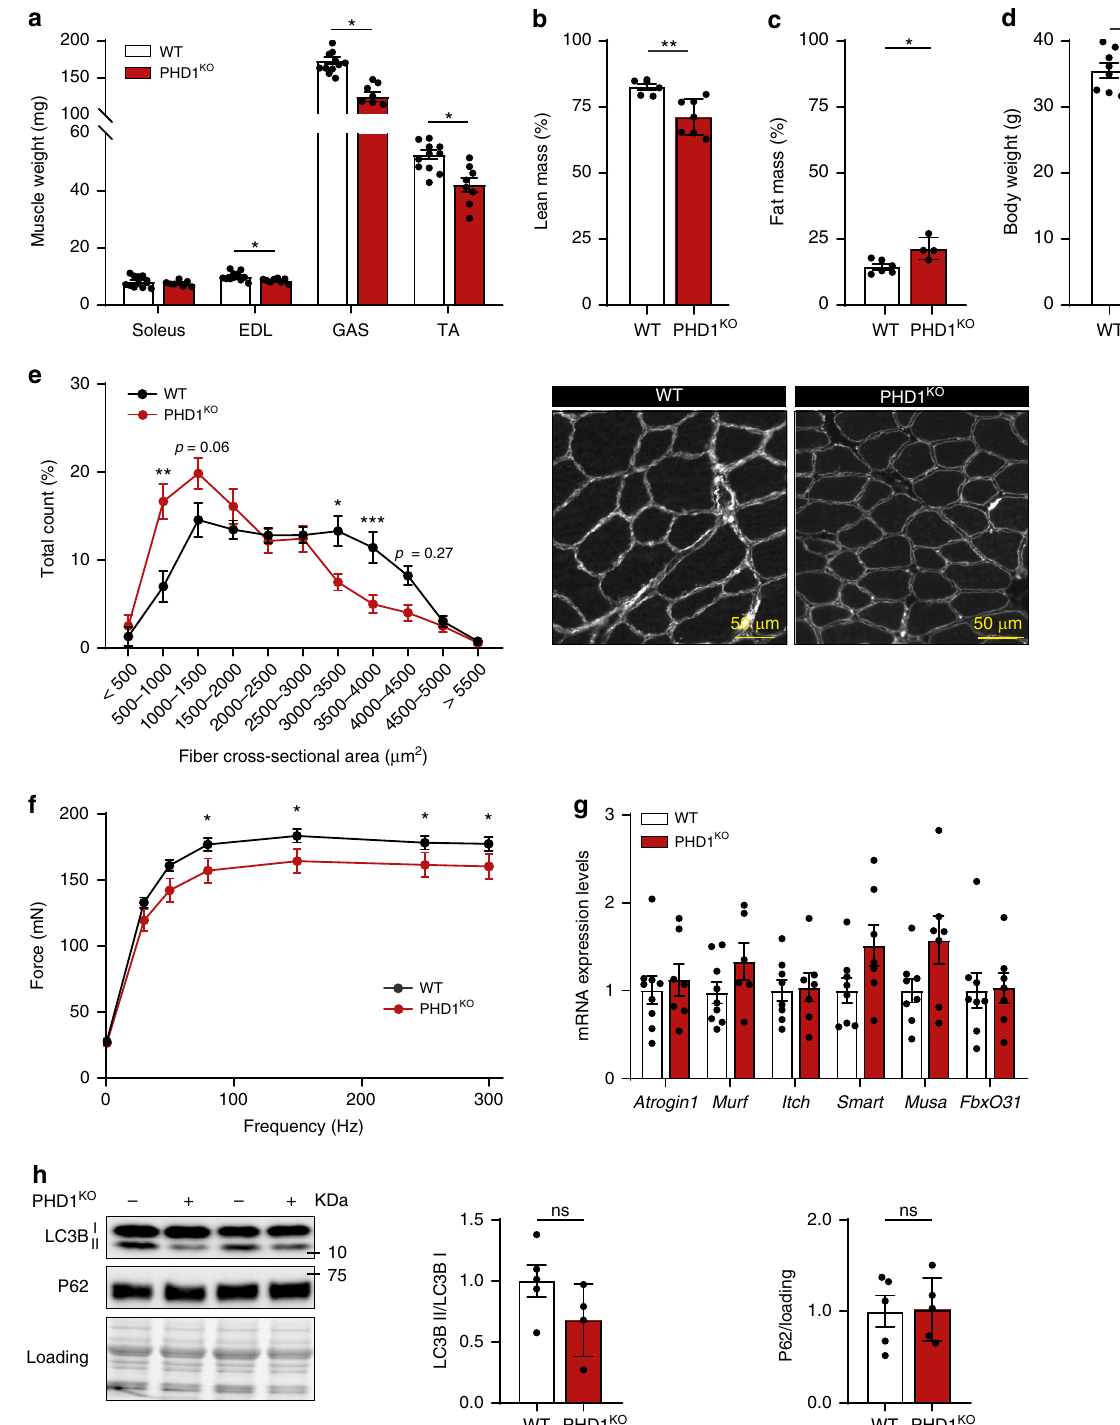
Fig. 1 Phd1 -de fi cient mice have lower muscle mass. Bar graphs showing muscle weight ( a ), lean mass ( b ), fat mass ( c ), and body weight ( d ) of WT (white bars) and PHD1 KO (red bars) male mice. e Quanti fi cation (left panel) and representative pictures (right panel) of fi ber cross sectional area distribution in WT (black line) and PHD1 KO (red line) TA muscle. f Force – frequency curve in ex vivo stimulated soleus from WT (black line) and PHD1 KO (red line) male mice. g mRNA expression levels of genes involved in ubiquitin-proteasome mediated protein degradation in TA muscle from WT (white bars) and PHD1 KO (red bars) female mice. h Representative pictures and quanti fi cation of western blot analysis of LC3B and P62 protein levels in TA muscle from WT (white bars) and PHD1 KO (red bars) female mice. Statistics: two-way ANOVA test, with a Holm – Sidak post hoc test ( e , f ) or unpaired t test ( a , b , c , d , g , h ) (* p < 0.05; ** p < 0.01; *** p < 0.001; ns not signi fi cant). Each dot represents a single mouse ( a , b , c , d , h ). Bar graphs and line graphs represent mean ± SEM (error bars). Data is represented as fold change to WT ( g , h ). EDL m. extensor digitorum longus , GAS m. gastrocnemius , TA m. tibialis anterior . See also Supplementary Fig. 1. Source data are provided as a Source Data fi